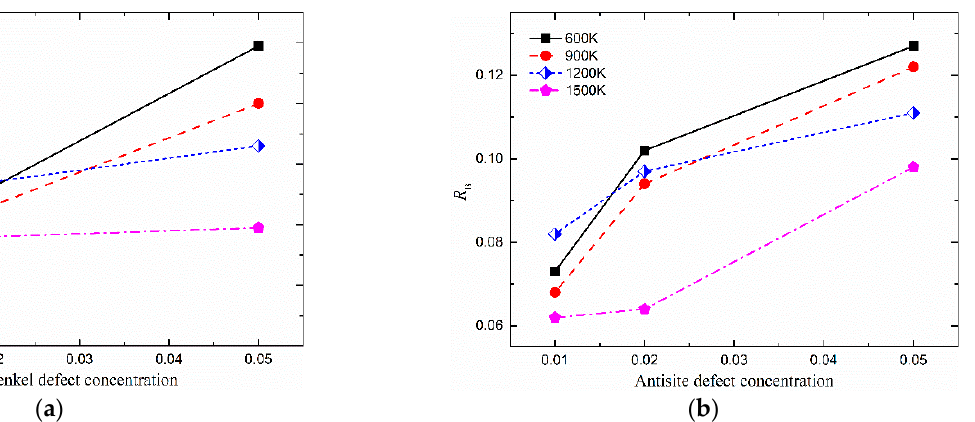
Figure 8. R B as a function of the concentration of Frenkel defects ( a ) and antisites ( b ) at different temperatures.